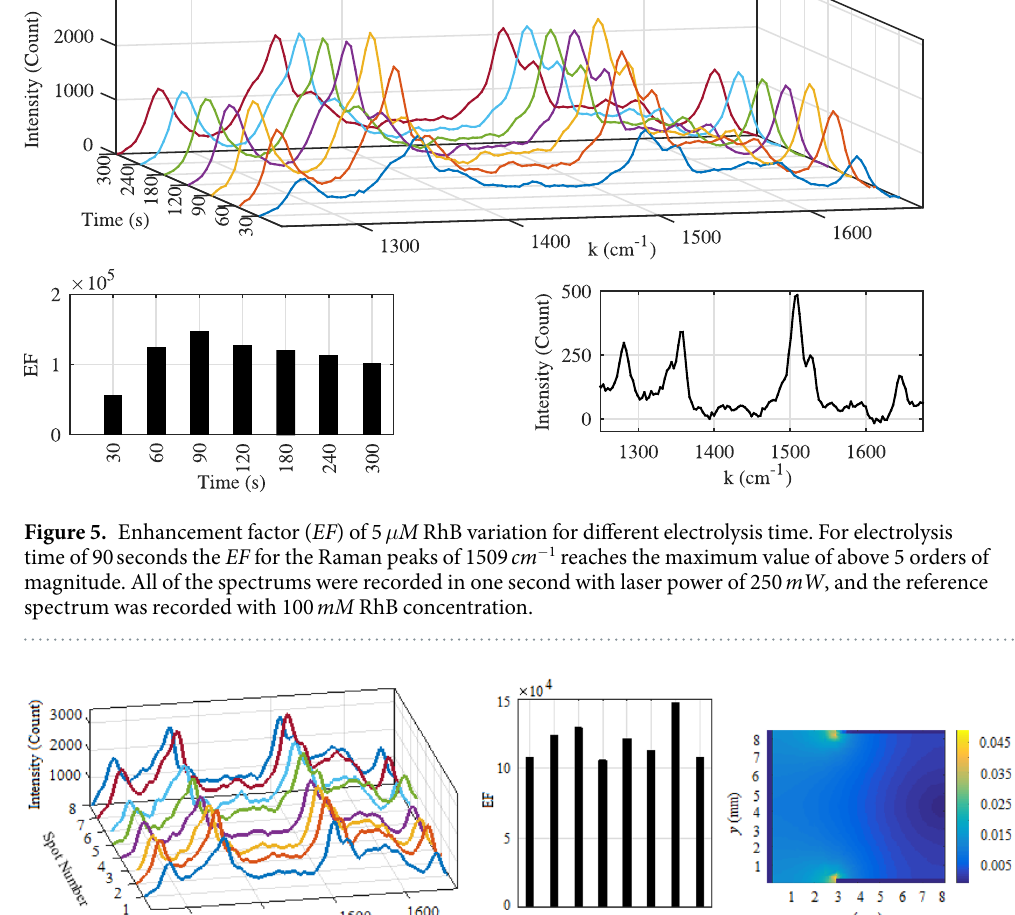
EF , roughly 1.5 × 10 5 , occurred at 90 seconds into the electrolysis then it started to reduce gradually, which after 5 minutes of electrolysis time the EF decreased to almost 75% of the maximum. This reduction in EF can be explained by the change in the dimensions of the nanoparticles on the anode surface. According to captured SEM images (see Fig. 4) from the anode surface, for 90 seconds electrolysis the average size of nanocubes is about 100 nm , while by increasing the electrolysis time to 5 minutes, the average size of the larger nanoparticles reaches to about 300 nm . Therefore a peak in EF is expected, as it will be explained in the discussion section, maximum enhancement should occur for surface plasmon resonance (SPR) wavelengths around 838 nm which corresponds to a nanoparticle size of about 100 nm . After 5 minutes of electrolysis there is still a group of 100 nm nanoparticles left but their number is smaller since some of them grew to larger sizes, therefore a decrease in EF is expected. The substrate EF uniformity for the Raman peak of 1509 cm − 1 was checked by measuring the EF on eight random spots through a roughly 1 cm 2 area of the anode surface after 90 seconds electrolysis. The EF variation through these spots had a relative standard deviation(RSD) of roughly 12 percent, and the spectrums and the EF factors of these spots are shown in Fig. 6. A uniform EF was expected from the surface since the current density over the anode surface is rather uniform due to our electrode placement, which leads to uniform nanoparticle production on the anode. Simulated current distribution in the cuvette is also shown in the same figure. We repeated similar electrolysis experiments with other metal electrodes including brass, Ag, Zn and Al which except brass, no Raman enhancement obtained. Enhancement from brass is understandable since it is an alloy of Cu and Zn. The obtained Raman signal from the brass anode surface is similar to that of copper, while for silver,